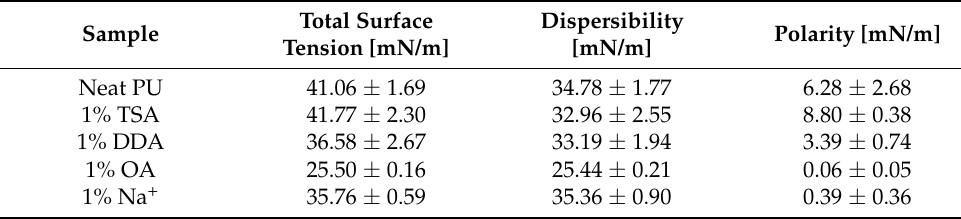
Table 7. Dispersive and polar components of the surface energy of selected samples.